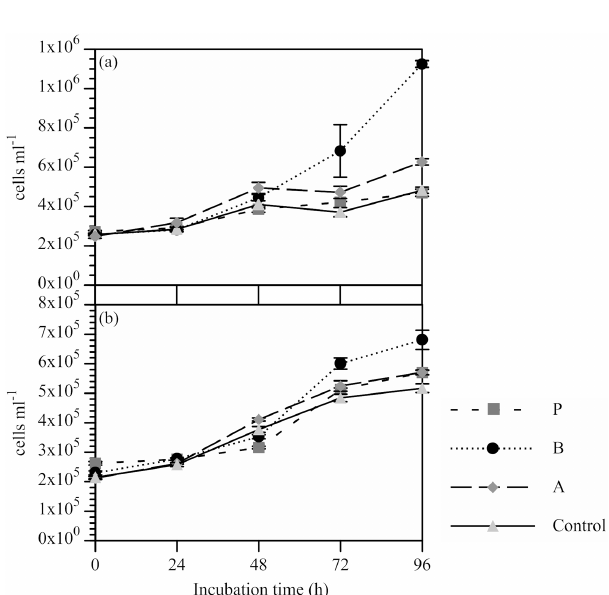
Figure 3. Cell-specific bacterial secondary production (mean ± SE, n = 3) in response to seawater acidified with 0.1 M HCl (A), bub- bled with CO 2 –air gas mixture (B) and CO 2 –air gas mixture in- troduced through gas-permeable silicon tubing (P). (a) Trial 1. (b) Trial